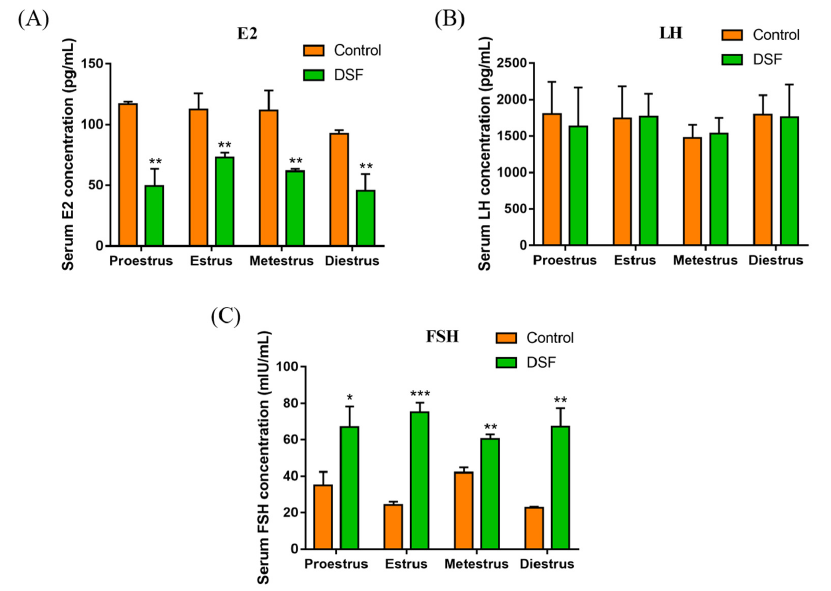
Figure 3. Effect of DSF on reproductive hormones in female mice. ( A ) Concentrations of E2 in serum of control group and DSF group mice during the estrous cycle; ( B ) concentrations of LH in serum of control group and DSF group mice during the estrous cycle; ( C ) concentrations of FSH in control group and DSF group mice during the estrous cycle; * p < 0.05, ** p < 0.01, *** p < 0.001. Control group, n = 12; 50 mg/kg DSF group, n = 12.